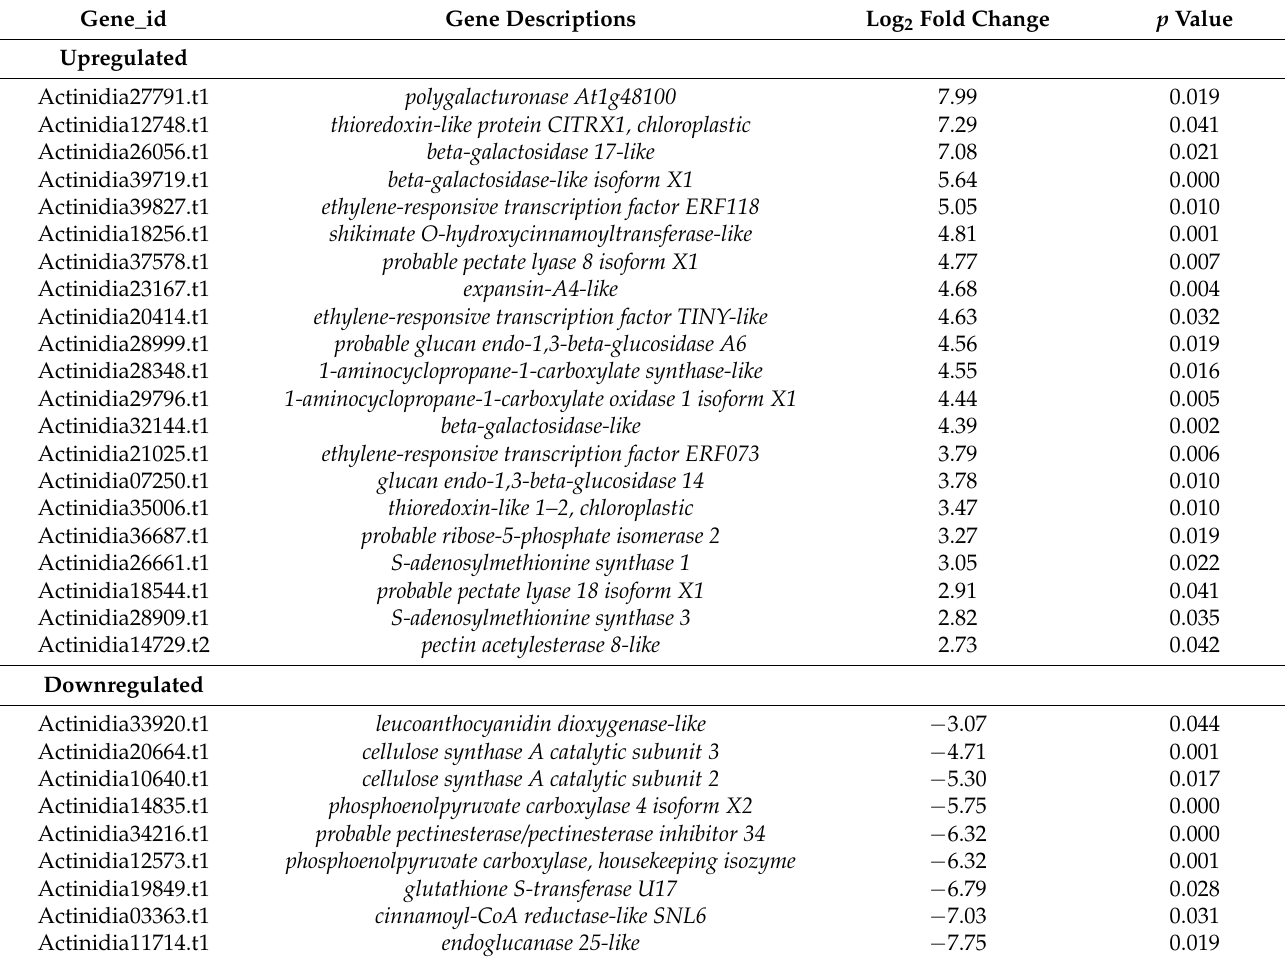
Table 4. List of DEGs exclusive to gold ‘Haeguem’ kiwifruit in the comparison of ethylene treated vs.